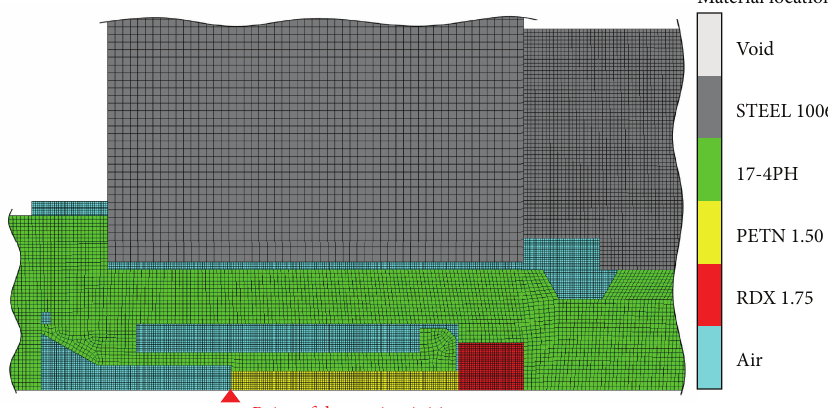
Figure 9: Euler part modeling for air, RDX, and